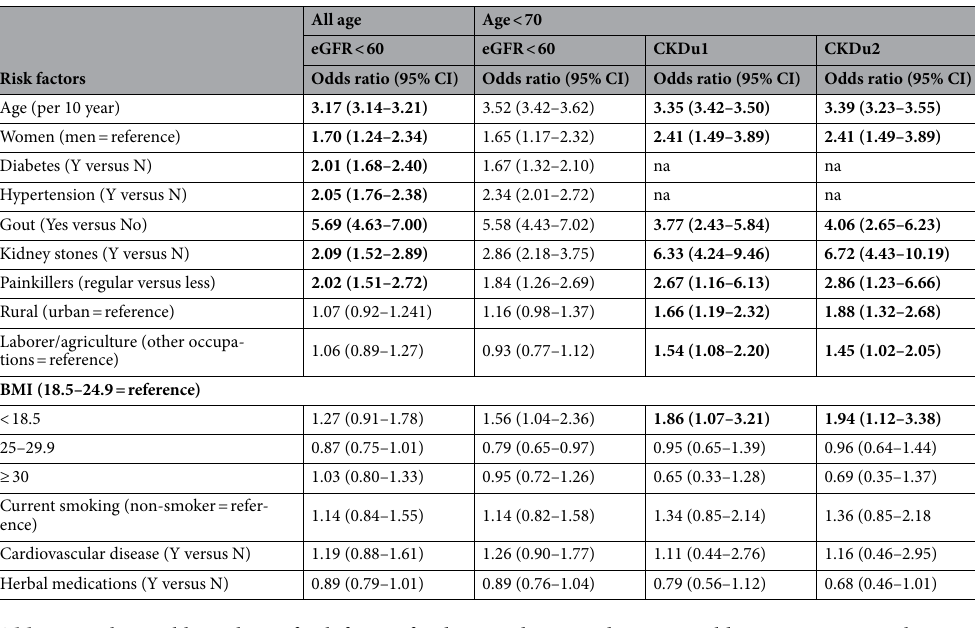
Table 3. Multivariable analysis of risk factors for decreased GFR and CKDU. Bold represent statistical significance; Risk compared to no CKD.